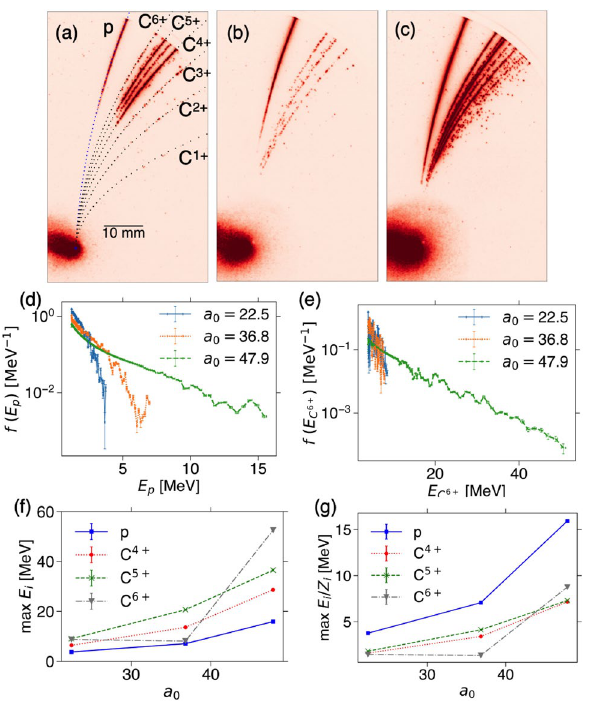
Figure 3. High contrast best focus shots: energy dependence. Same as Fig. 2 except for 8-layer LSG with best focus: ( a ) 4.24 J, I = 1.06 × 10 21 W cm − 2 , a 0 = 22.5 , ( b ) 11.4 J, 2.86 × 10 21 W cm − 2 , a 0 = 36.8 , and ( c ) 19.3 J, 4.83 × 10 21 W cm − 2 , a 0 = 47.9